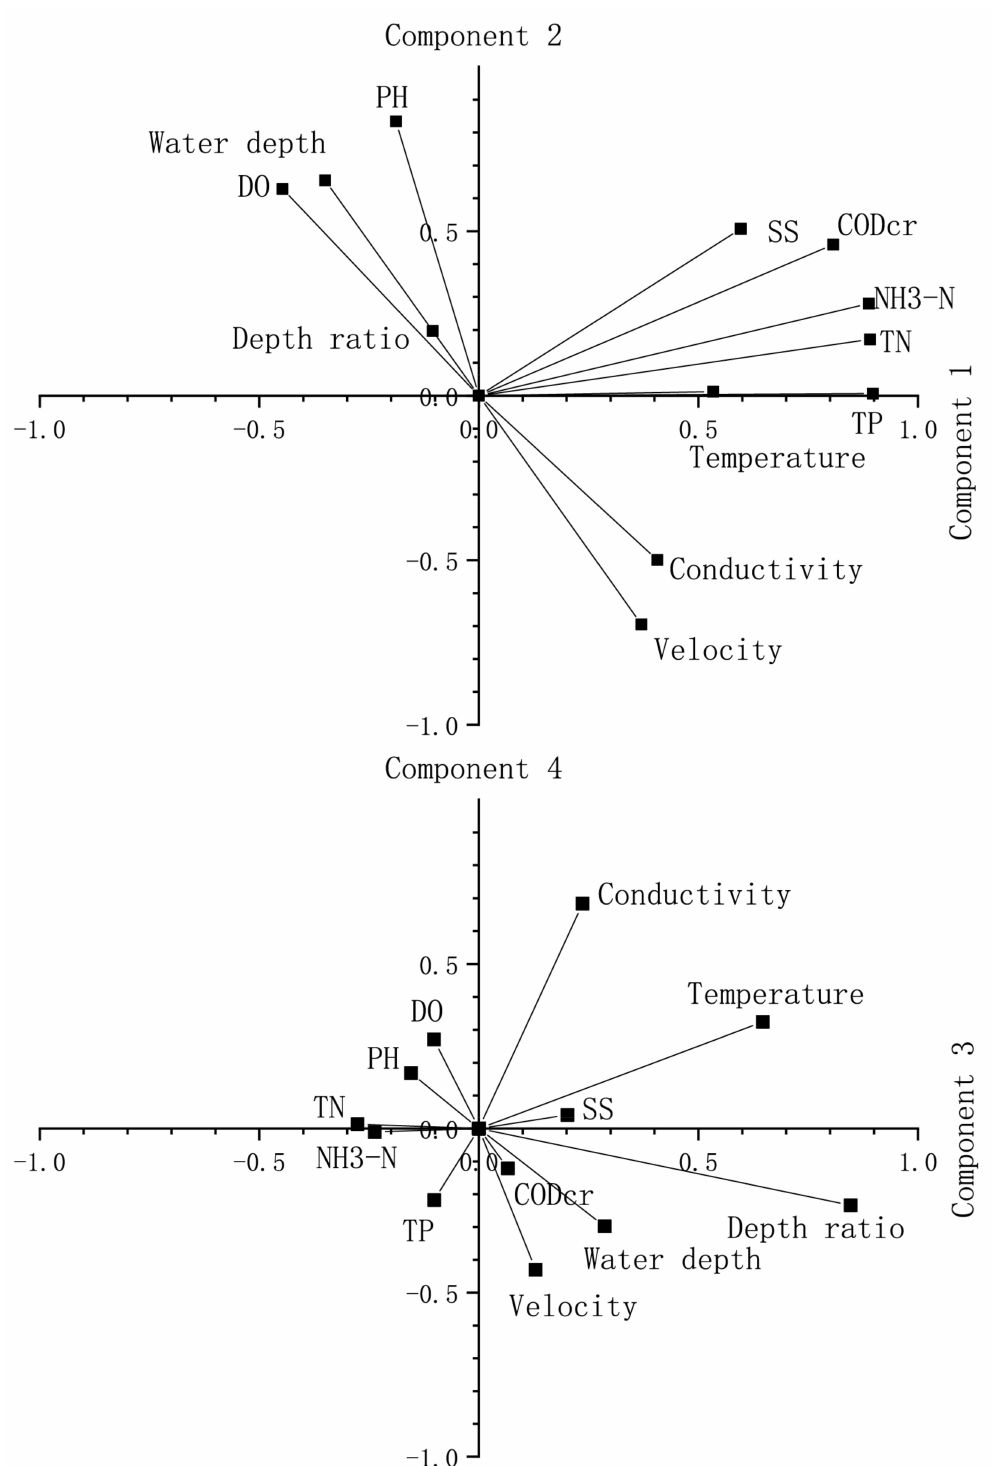
Figure 4. Results of the principal component load for various water quality